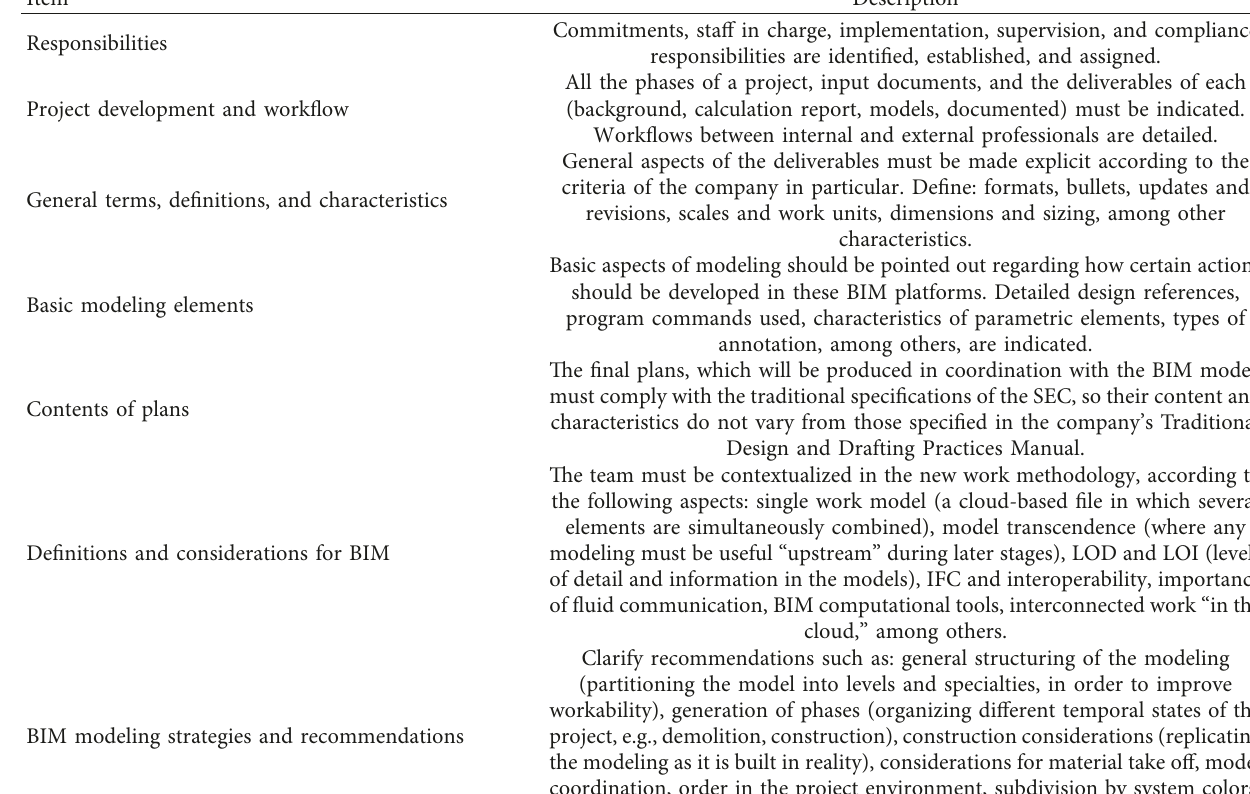
Table 6: Recommendations for BIM